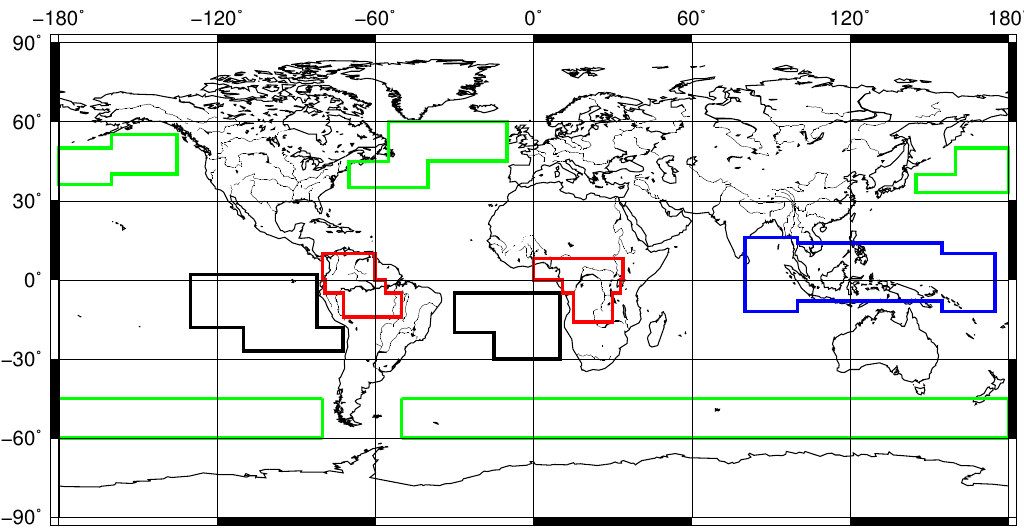
Fig. 9. Schematic of regions chosen for statistical comparison. Tropical Continental zones (red), Tropical maritime convective zone (blue), subsidence zones (black) and Westerlies